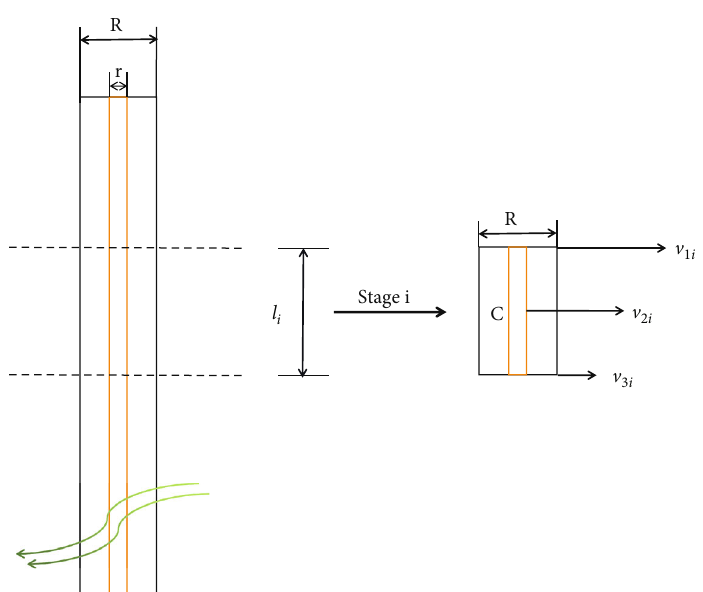
Figure 9: Schematic diagram of borehole kinetic energy calculation.